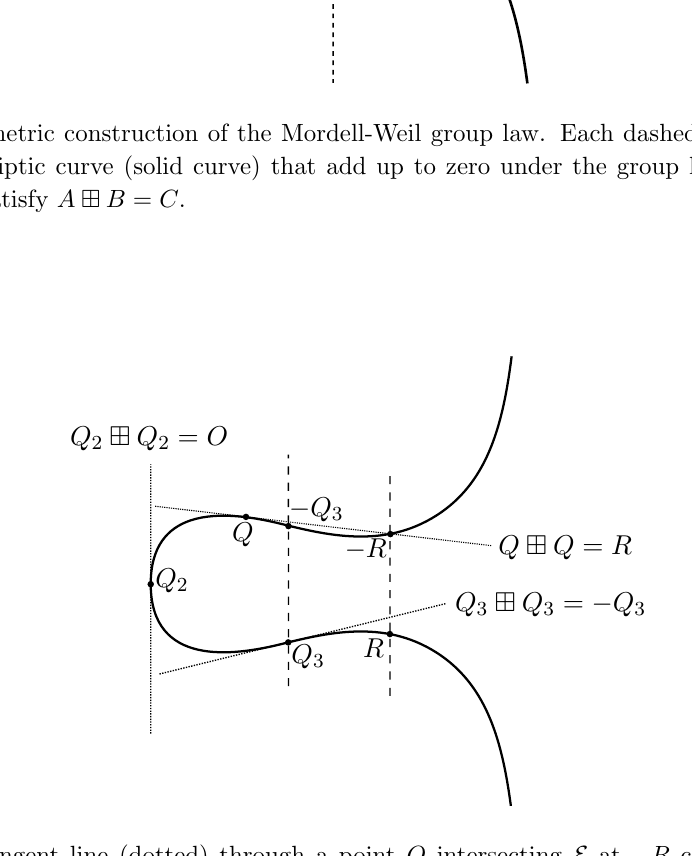
Figure 5 . A tangent line (dotted) through a point Q intersecting E at (cid:0) R corresponds to the Mordell-Weil relation Q (cid:1) Q (cid:1) ( (cid:0) R ) = O , 2 Q = R . If the tangent line at Q 2 is vertical, it intersects E only at in(cid:12)nity, so 2 Q 2 (cid:1) O = O . A tangent line at an in(cid:13)ection point Q 3 can be viewed as the limit of taking Q ! Q 3 , which also sends R to Q 3 . So 2 Q 3 = (cid:0) Q 3 , 3 Q 3 = O